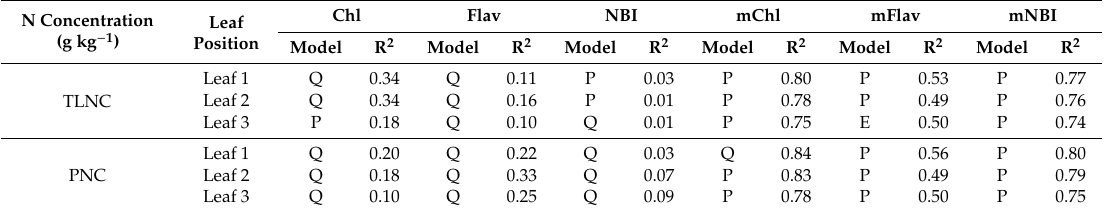
Table 4. Coe ffi cients of determination (R 2 ) for the relationships between Dualex 4-based parameters of three di ff erently positioned leaves and two N status indicators (TLNC and